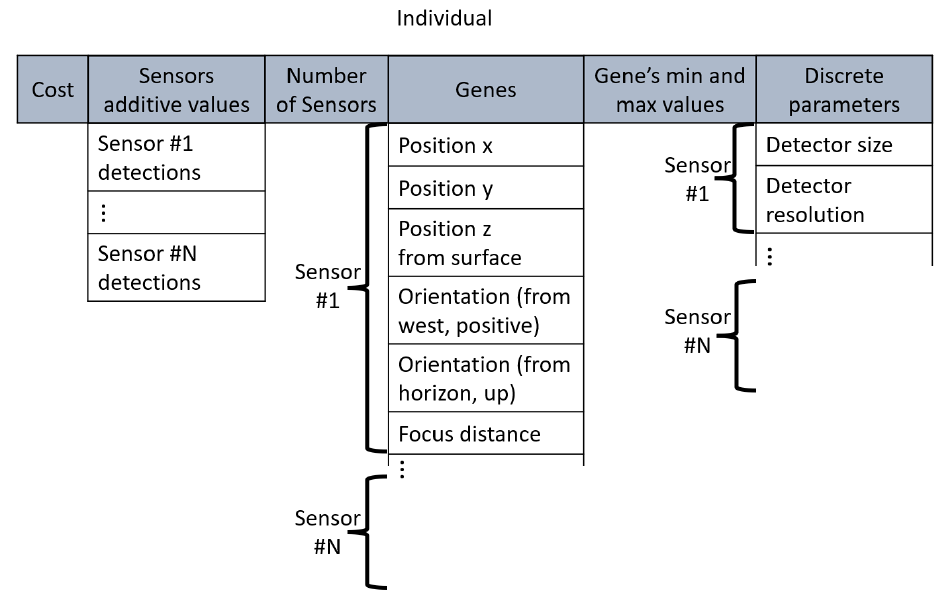
Figure 6. Structure of an